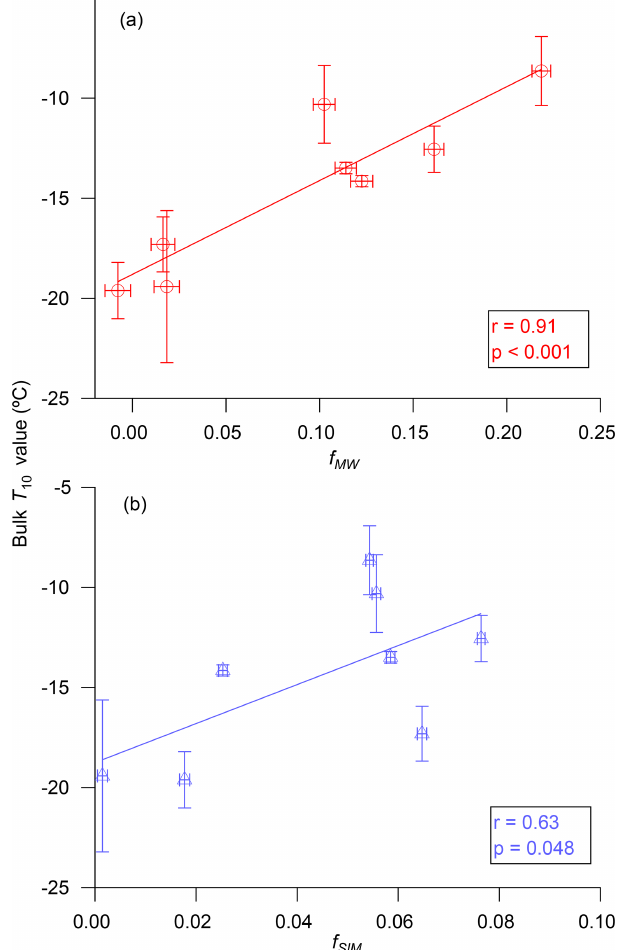
Figure 6. Relationships between T 10 values for bulk seawater and (a) the water volume fractions for meteoric water, f MW , and (b) the water volume fractions for sea-ice melt, f SIM . The x error bars are due to the uncertainties in seawater salinities and seawater δ 18 O values used for calculating f MW and f SIM . For further details see Sect. 2.4. The y error bars correspond to the 95% confidence inter- val for three repeat experiments.